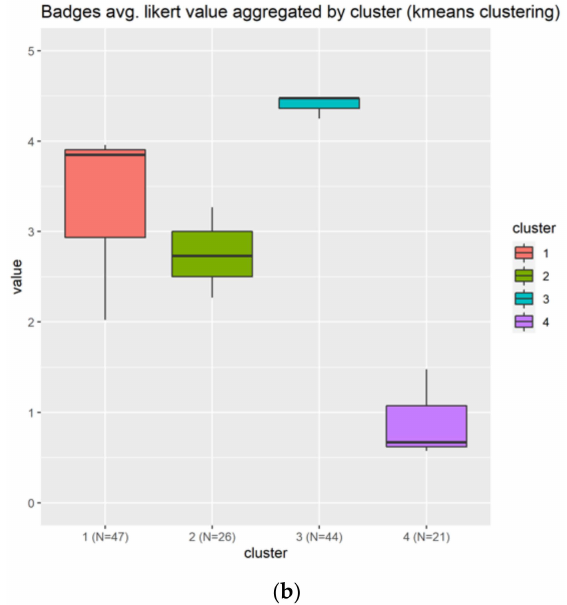
Figure 16. This figure shows the results for the Badges. Each color identifies a different cluster. The ( a ) subplots show the results based on each question, meanwhile the ( b ) shows the information condensed in